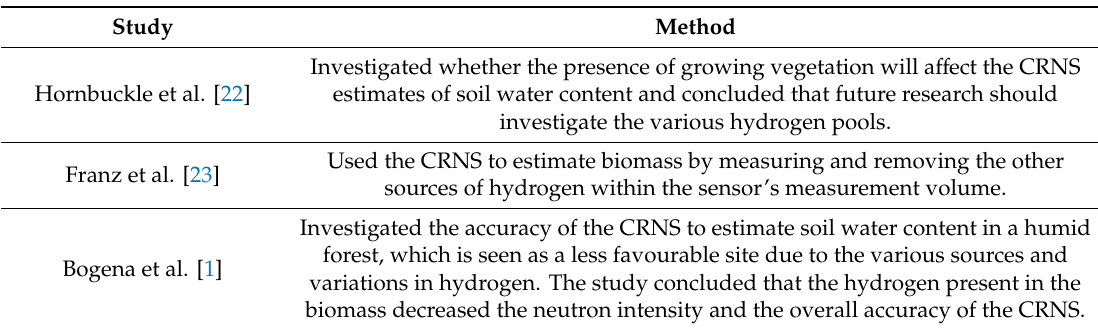
Table 1. Cosmic ray neutron sensor studies involving